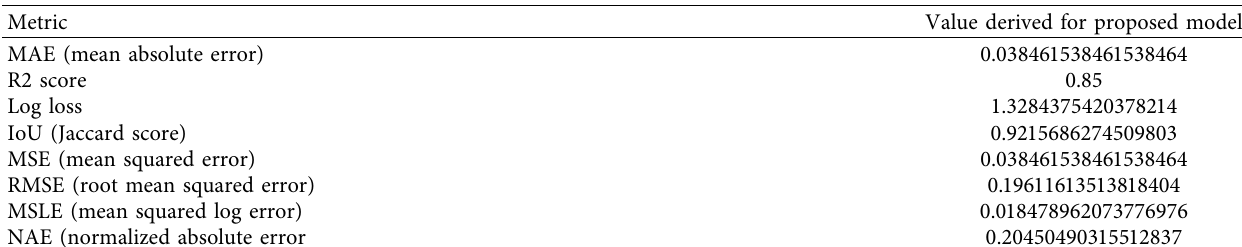
Table 3: Model metrics.